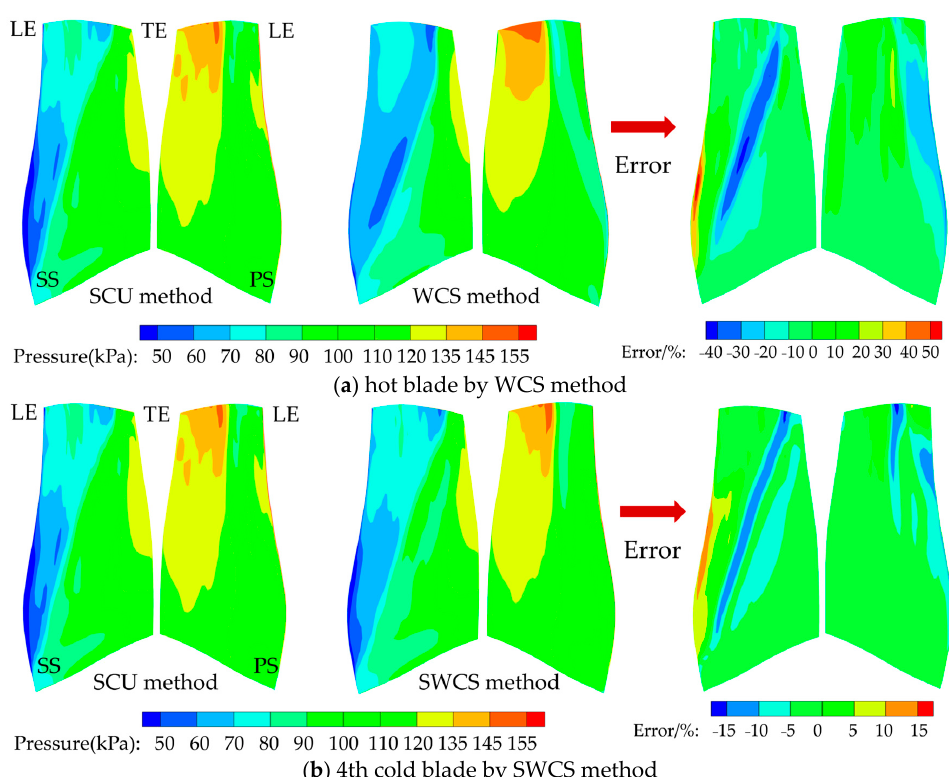
Figure 17. The steady pressure distribution of the 13th convergent cold blade in the SCU method is regarded as the benchmark. The result of the WCS method is from the hot blade shape, and that of the SWCS method is from the 4th cold blade.